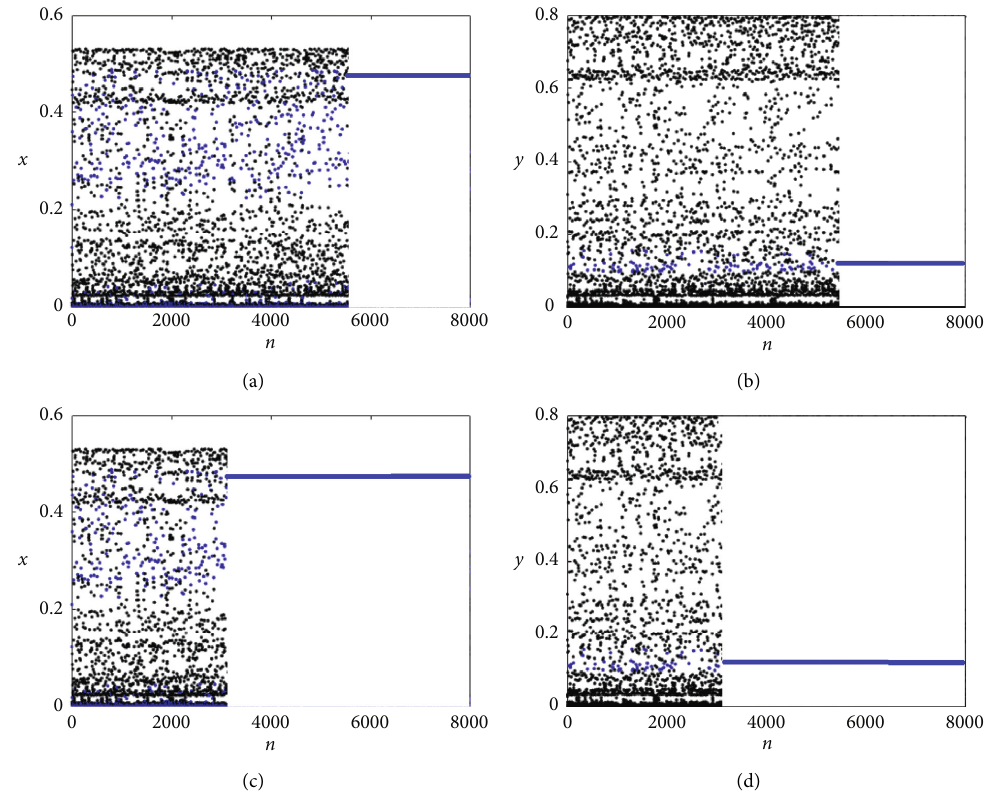
Figure 5: Control of period-1 of Hassell mapping.